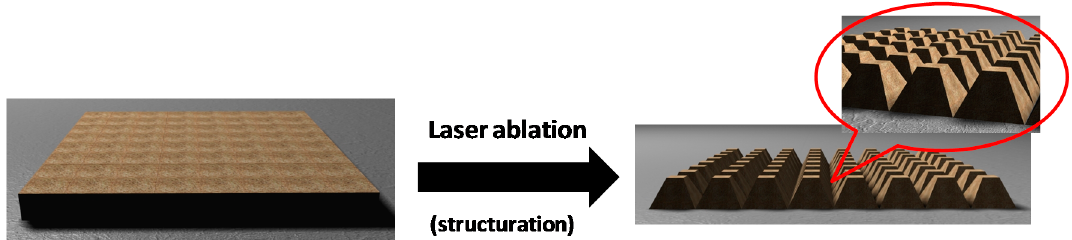
Figure 2. Structuration forming micropillars by laser ablation.